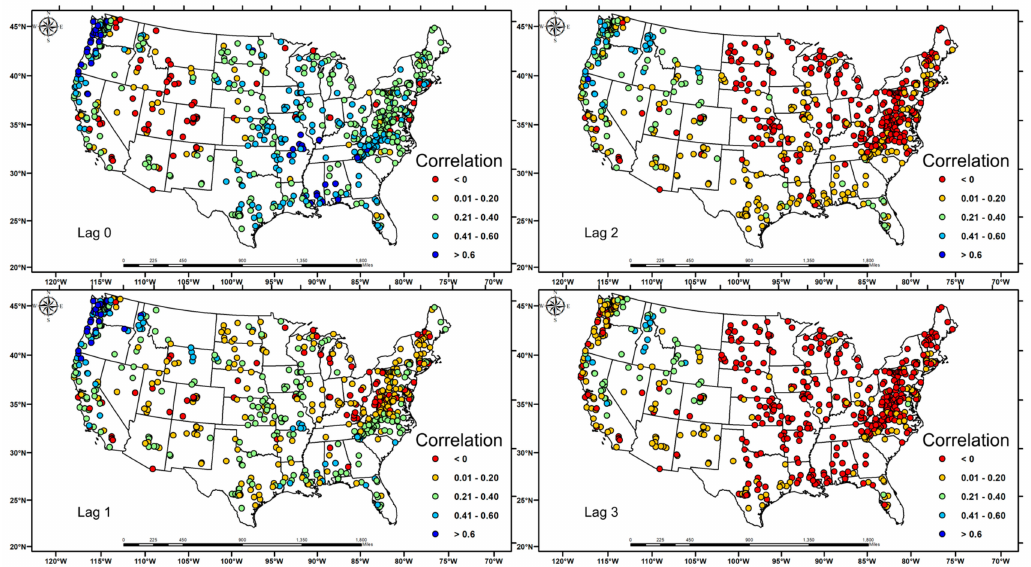
Figure 3. Spatial variation of correlation coe ffi cients of precipitation-streamflow for di ff erent lag months.